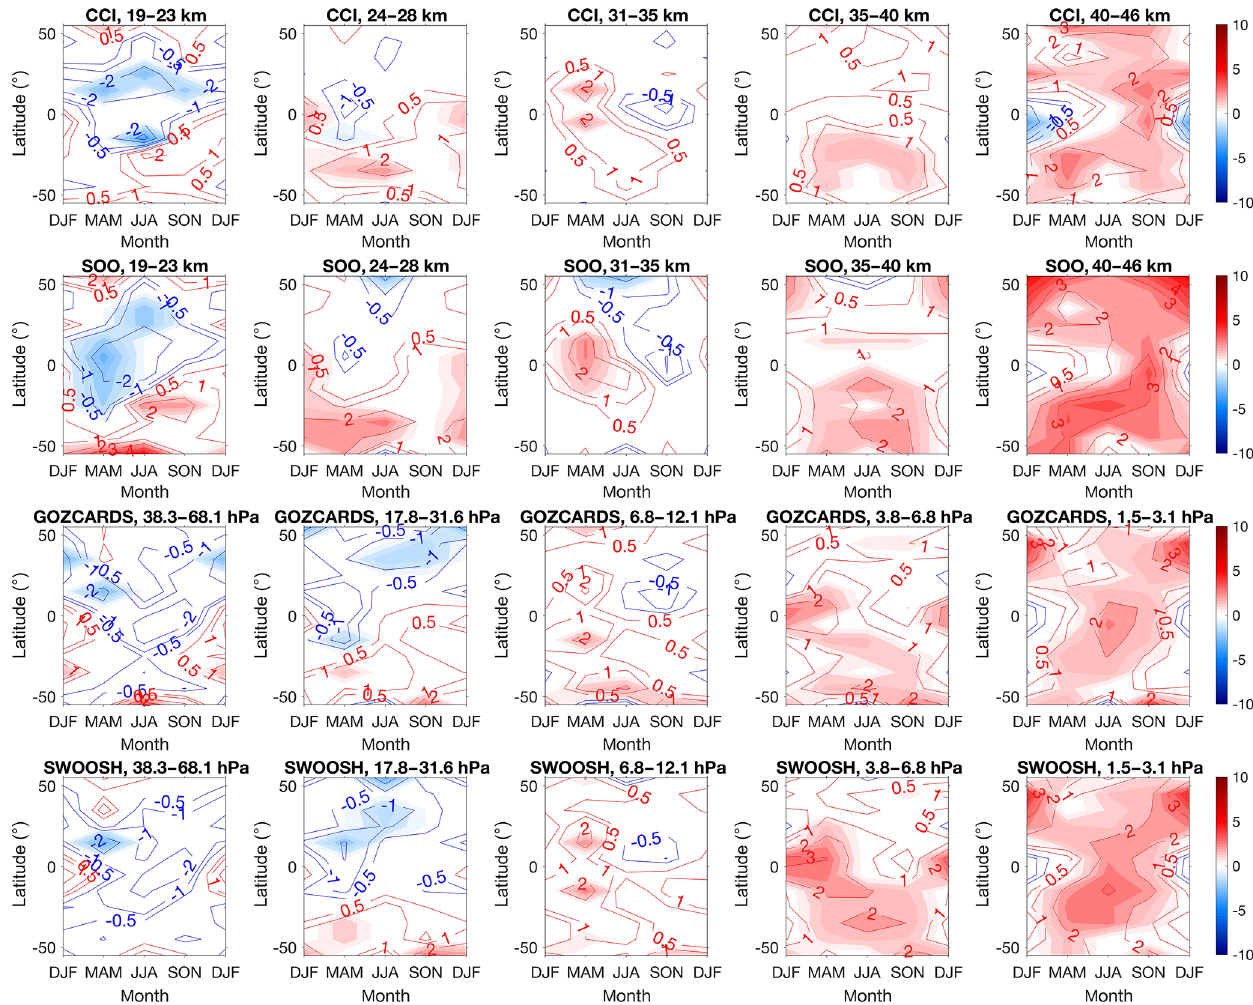
Figure 3. Latitude–season variation of linear trends in ozone for each of the merged data sets calculated over 2000–2018 for five selected altitude/pressure ranges. The shading denotes trends that are significant at the 95% level. Pressure ranges correspond approximately to altitude